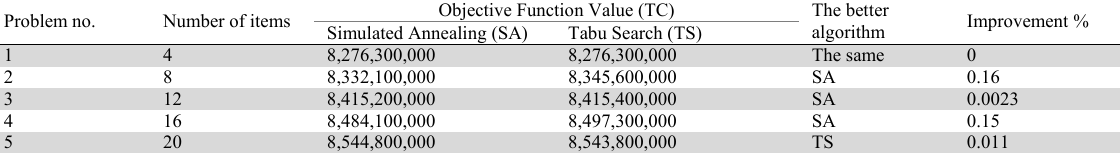
Table 2 represents the crisp objective function value of each example which are calculated by two metaheuristic approaches (SA, TS). Moreover, computational time which is needed to tackle the problem are reported for both algorithms under different situations in Tables 4 and